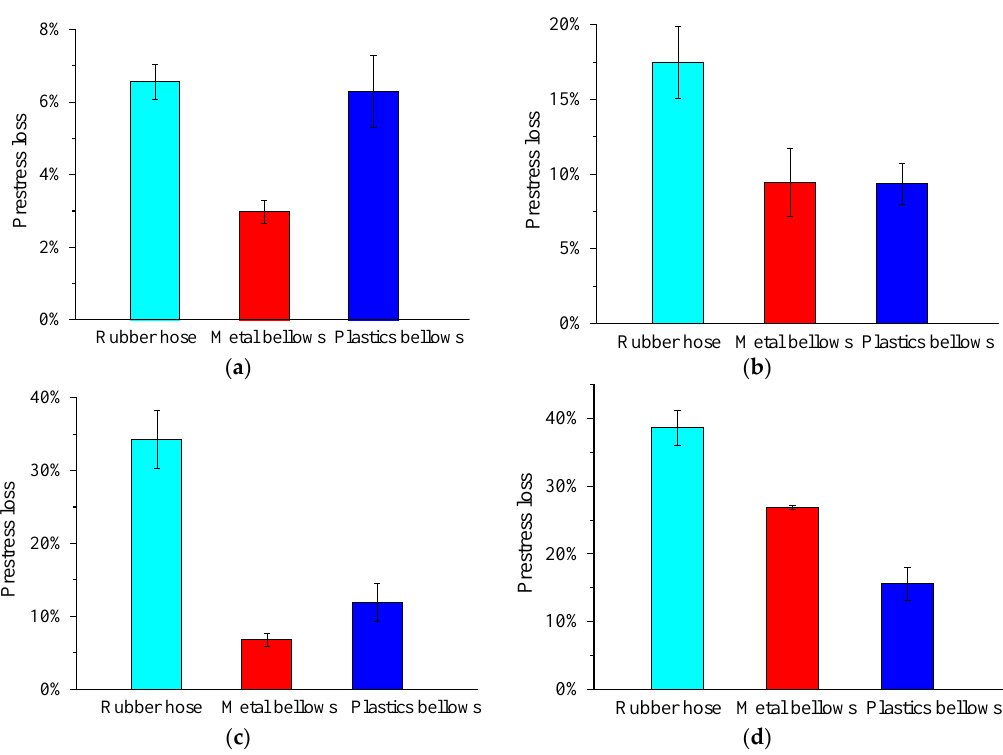
Figure 14. Average pre-stress losses: ( a ) 1 wire with straight duct; ( b ) 1 wire with curve duct; ( c ) 19 wires with straight duct; and ( d ) 19 wires with curve duct.